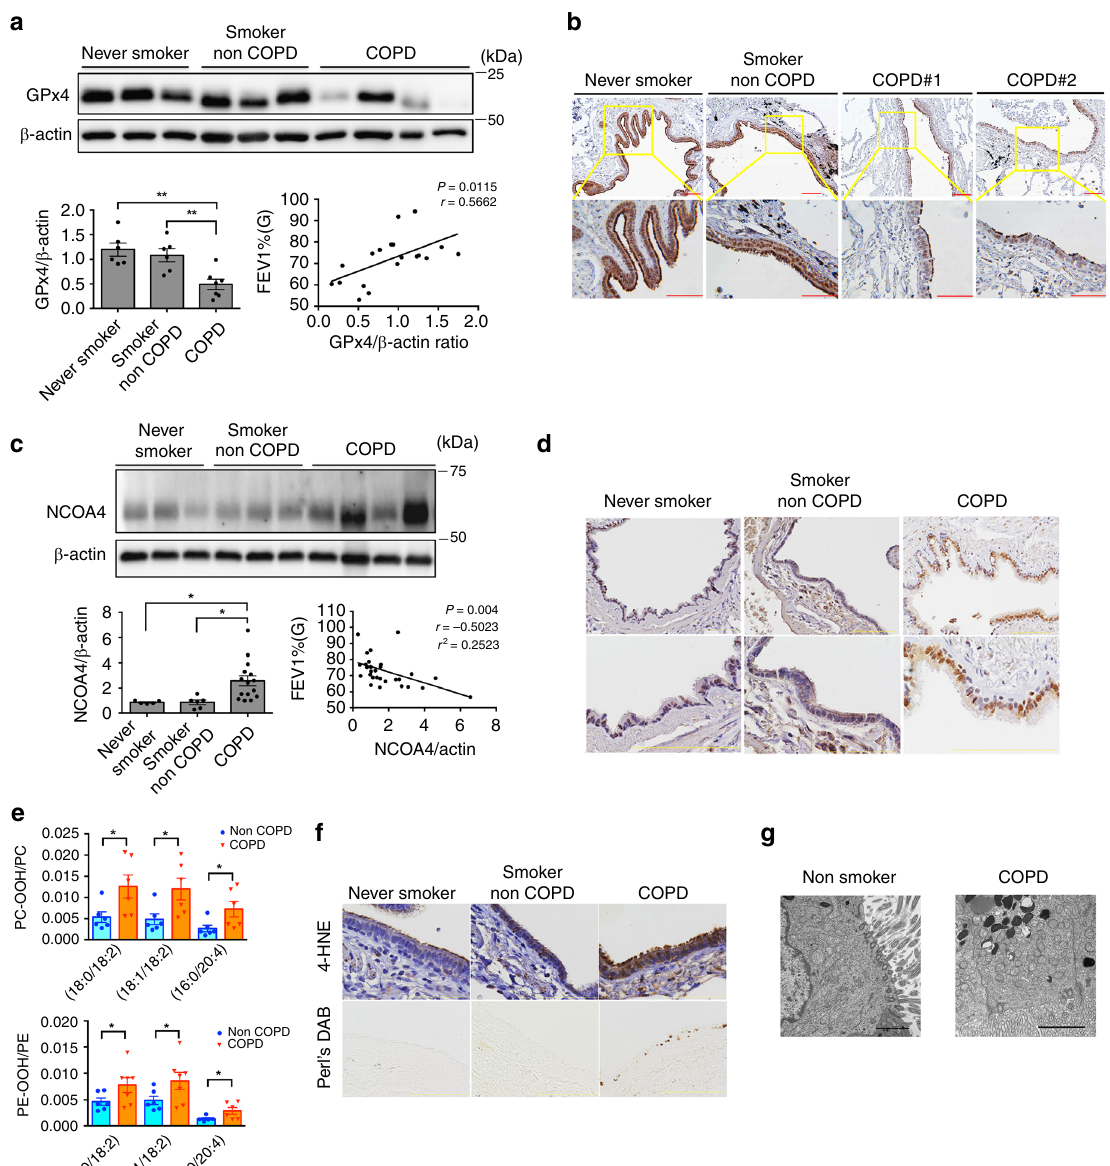
Fig. 5 Involvement of ferroptosis in human COPD lung. a WB showing expression levels of GPx4 and β -actin in HBECs isolated from never smokers ( n = 6) or non COPD smokers ( n = 6) or COPD patients ( n = 7). The bar chart shown represent the mean ± SEM. * P < 0.05, ** P < 0.01 by one-way ANOVA followed by Tukey ’ s multiple comparisons test. The correlation analysis between GPx4 expression level and the percentages of FEV1/FVC ( n = 19) in HBECs from never smokers, non-COPD smokers, and COPD patients. b IHC of GPx4 in never smoker, healthy smoker and COPD lung. Original magni fi cation ×400. Bar = 100 µ m. c WB showing expression levels of NCOA4 and β -actin in lung homogenates from never smokers ( n = 5) or non COPD smokers ( n − 6) or COPD patients ( n = 15). The bar chart shown represent the mean ± SEM. * P < 0.05, ** P < 0.01 by one-way ANOVA followed by Tukey ’ s multiple comparisons test. The correlation analysis between NCOA4 expression level and the percentages of FEV1/FVC ( n = 31) in human lung homogenates from never smokers ( n = 10), non-COPD smokers ( n = 6), and COPD patients ( n = 15). d IHC of NCOA4 in human never smoker, healthy smoker and COPD lung. Original magni fi cation ×400. Bar = 100 µ m. e LC-MS analysis of PC and their oxidation products in never smokers, smoker non- COPD, and COPD lung homogenates. MS of precursor ion scanning of m/z 184 in the positive ion mode were analyzed. PC-OOH/PC (18:0/18:2), (18:1/ 18:2), (16:0/20:4) shown in upper panel. non-COPD, n = 6; COPD, n = 6. LC-MS analysis of PE and their oxidation products in never smokers, smoker non- COPD, and COPD lung homogenates. * P < 0.05 by student ’ s t -test. MS of neutral loss scanning of 141 Da in the positive ion mode were analyzed. PE-OOH/ PE (18:0/18:2), (18:1/18:2), (16:0/20:4) were shown in lower panel. non-COPD, n = 6; COPD, n = 7. * P < 0.05 by by student ’ s t -test. f Perls ’ DAB and 4- HNE staining in never smoker, healthy smoker and COPD lung tissues (original magni fi cation, ×400). Bar = 100 µ m. g Representative TEM images of bronchial epithelial cells in never smoker lung and COPD lung (Brinkman Index = 2100, FEV1% = 62.5%). Scale bars ;2 µ m. Throughout, n = independent